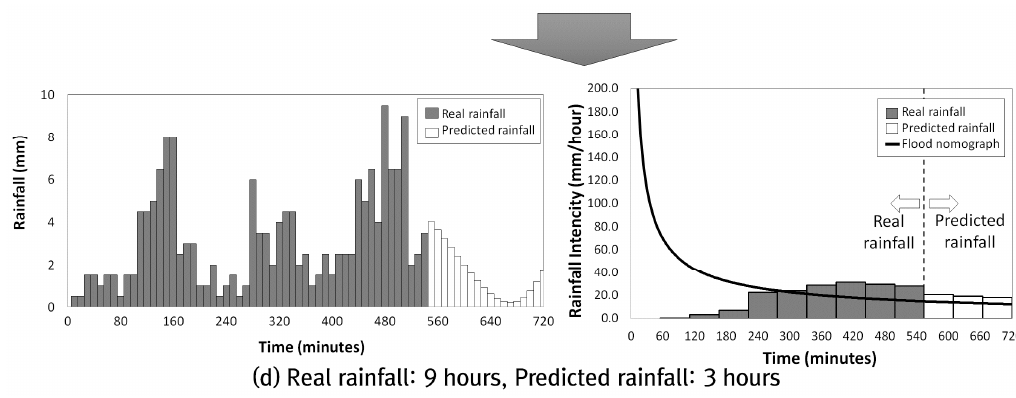
Figure 8. Application of rainfall to the flood nomograph.